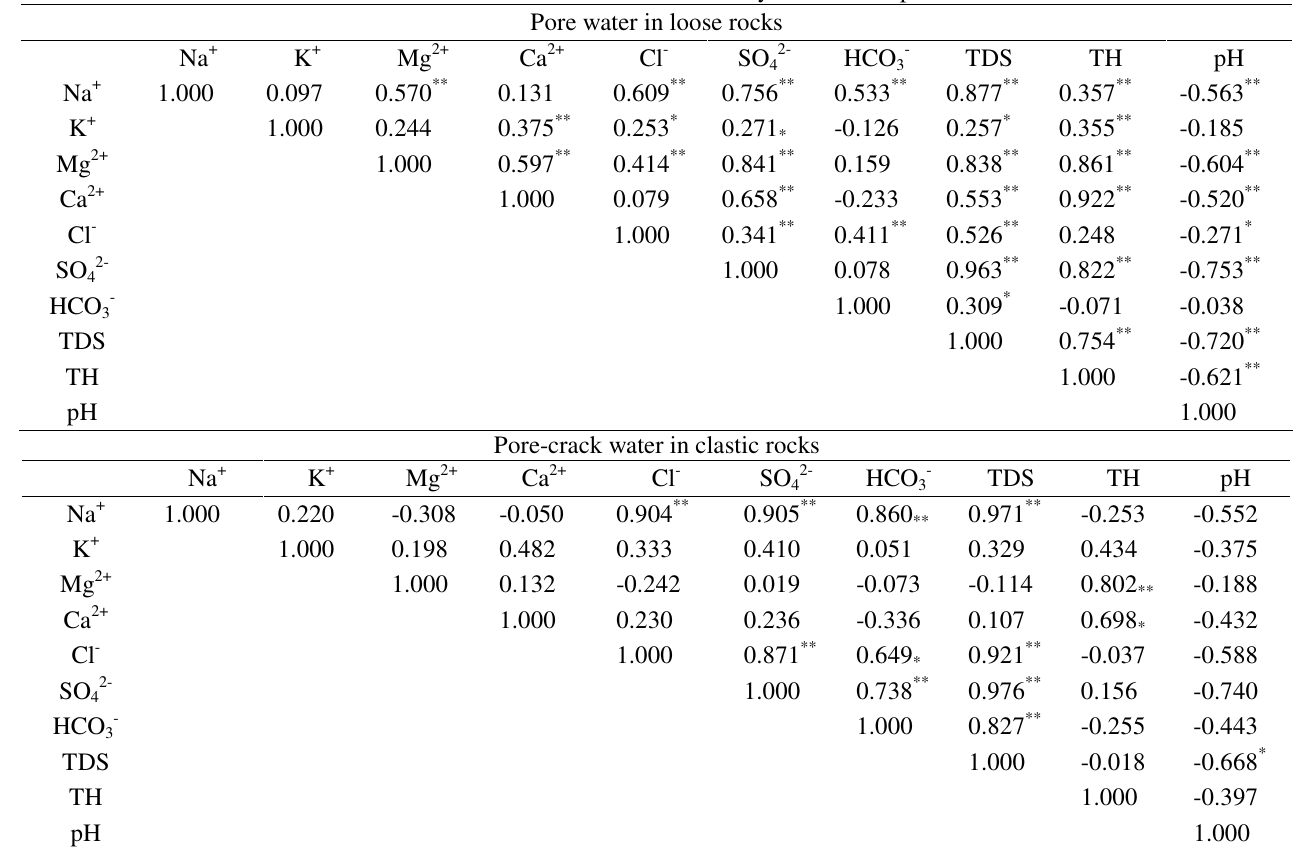
Table 2. Pearson correlation coefficients of hydrochemical